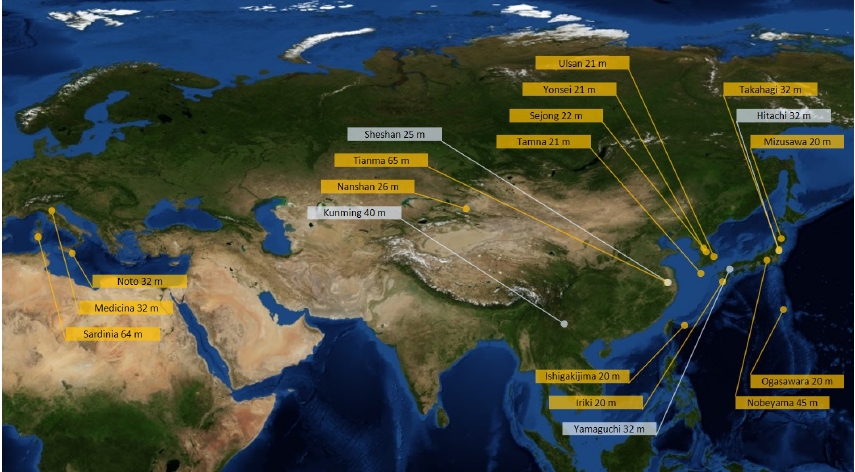
Figure 3. Locations of telescopes consisting of EATING VLBI including 19 telescopes (16 EAVN telescopes and 3 Italian telescopes). Telescope names and locations are overlaid on ‘the Blue Marble’ image (credit of the ground image: NASA Earth Observatory (https://earthobservatory.nasa.gov/, 15 January 2023).